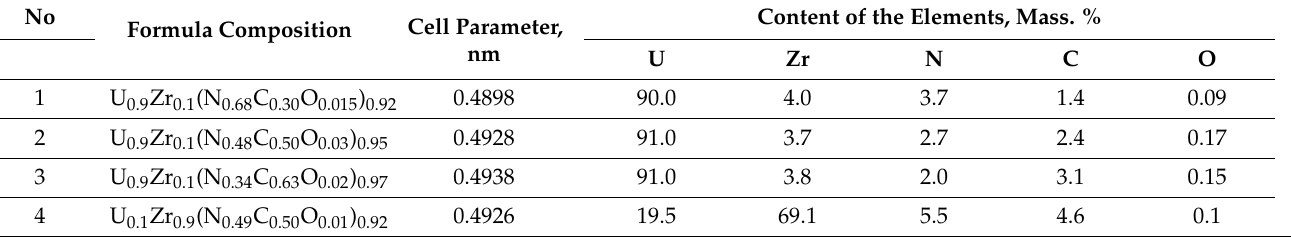
Table 2. The chemical composition, cubic lattice period of the investigated uranium-zirconium carbonitrides.